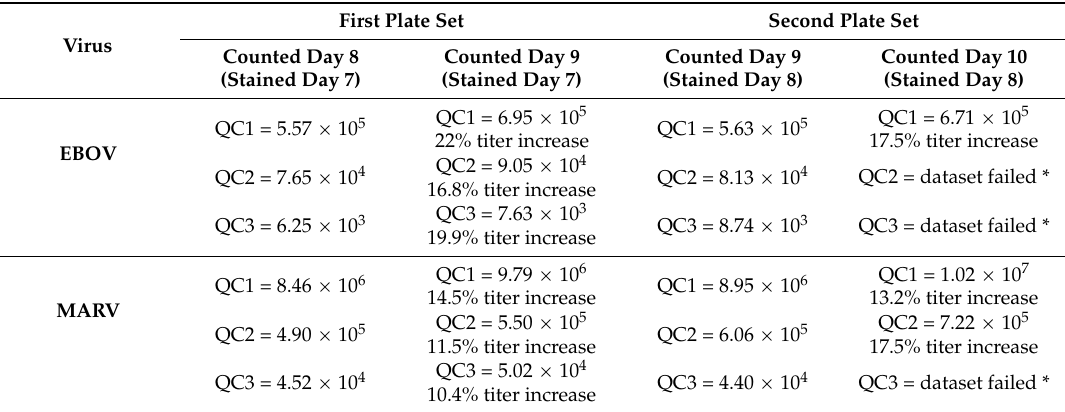
Table 7. Counting on one and two days following staining is an acceptable practice for the validated plaque